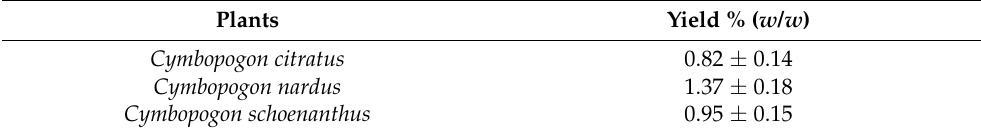
Table 1. Extraction yields of essential oils from three aromatic plants.